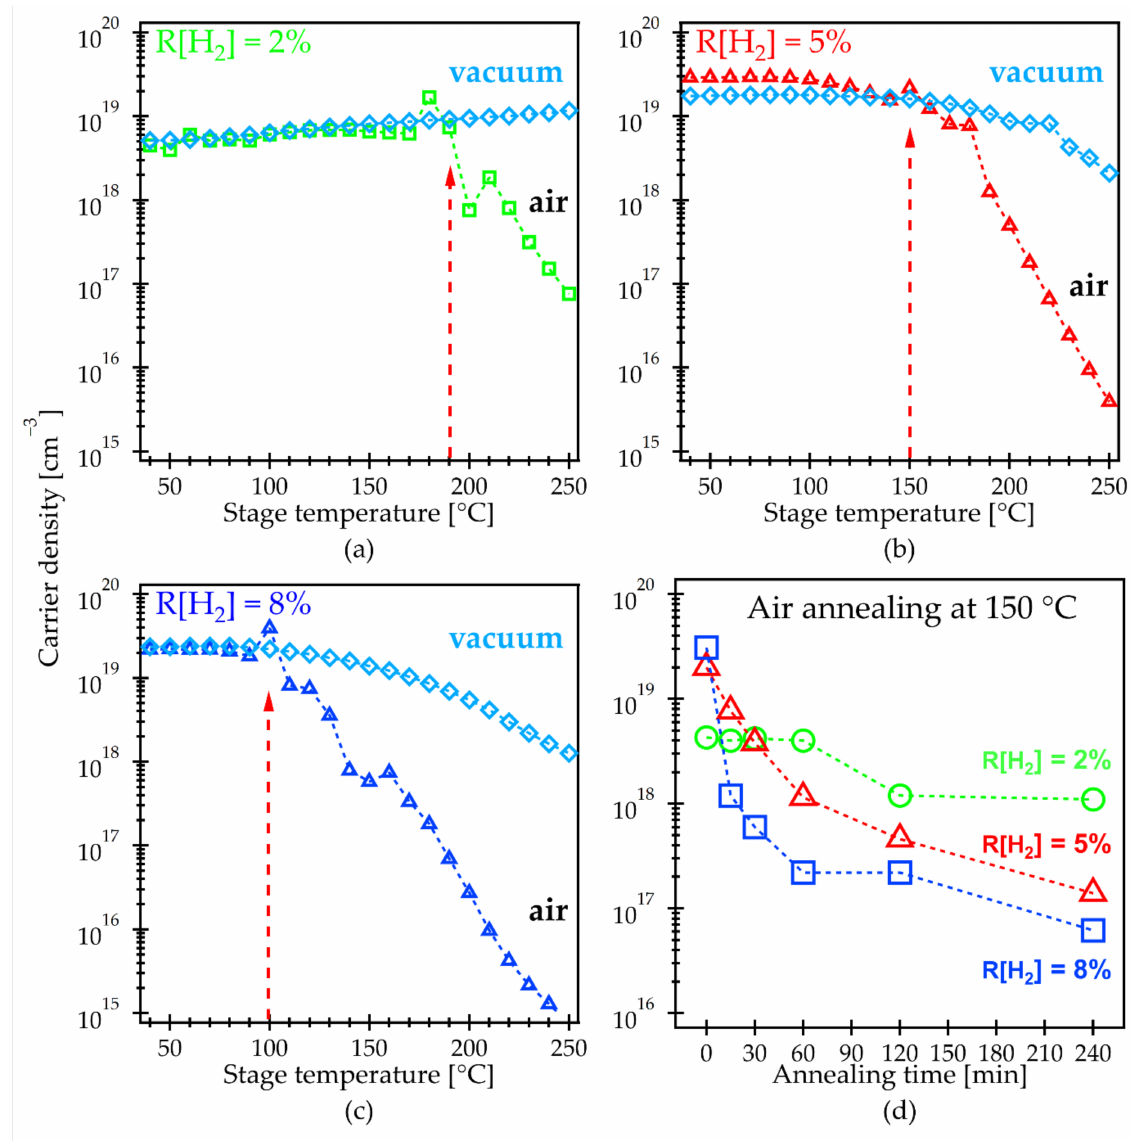
Figure 2. Carrier density of H doped IGZO films obtained from the in situ Hall measurement performed in air and vacuum atmosphere: ( a ) R[H 2 ] = 2%; ( b ) R[H 2 ] = 5%; ( c ) R[H 2 ] = 8%; ( d ) Carrier density variation as a function of annealing time at fixed temperature of 150 ◦ C performed in